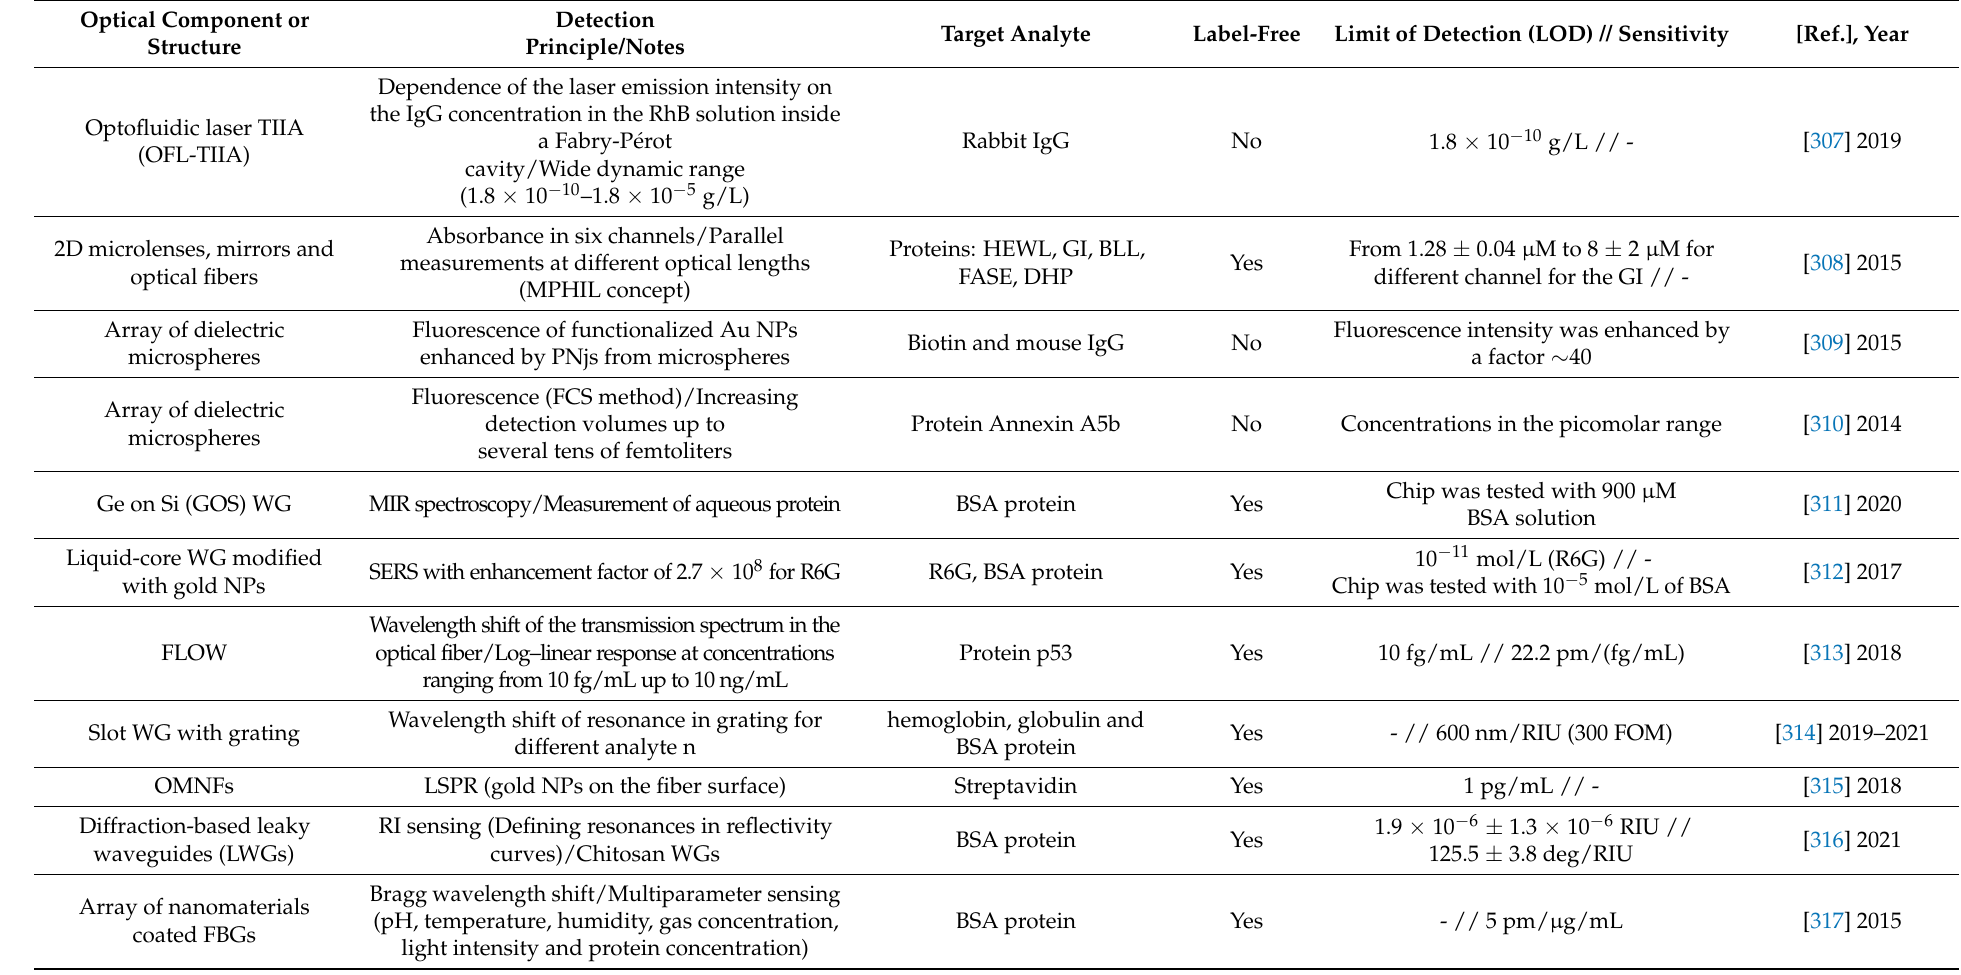
Table 7. Some examples of the applying of integrated optical elements in microfluidics for protein detection in recent